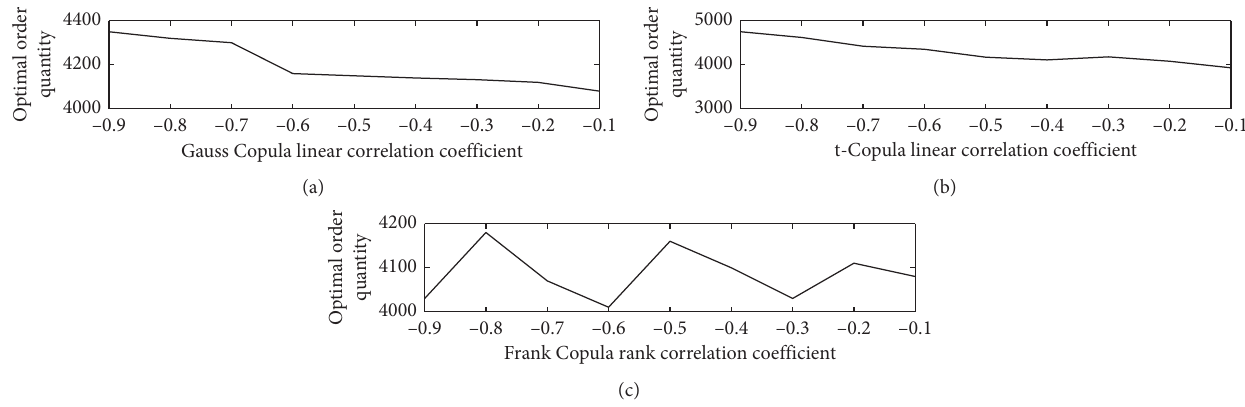
Figure 5: The impact of correlation on ordering strategy in different Copula